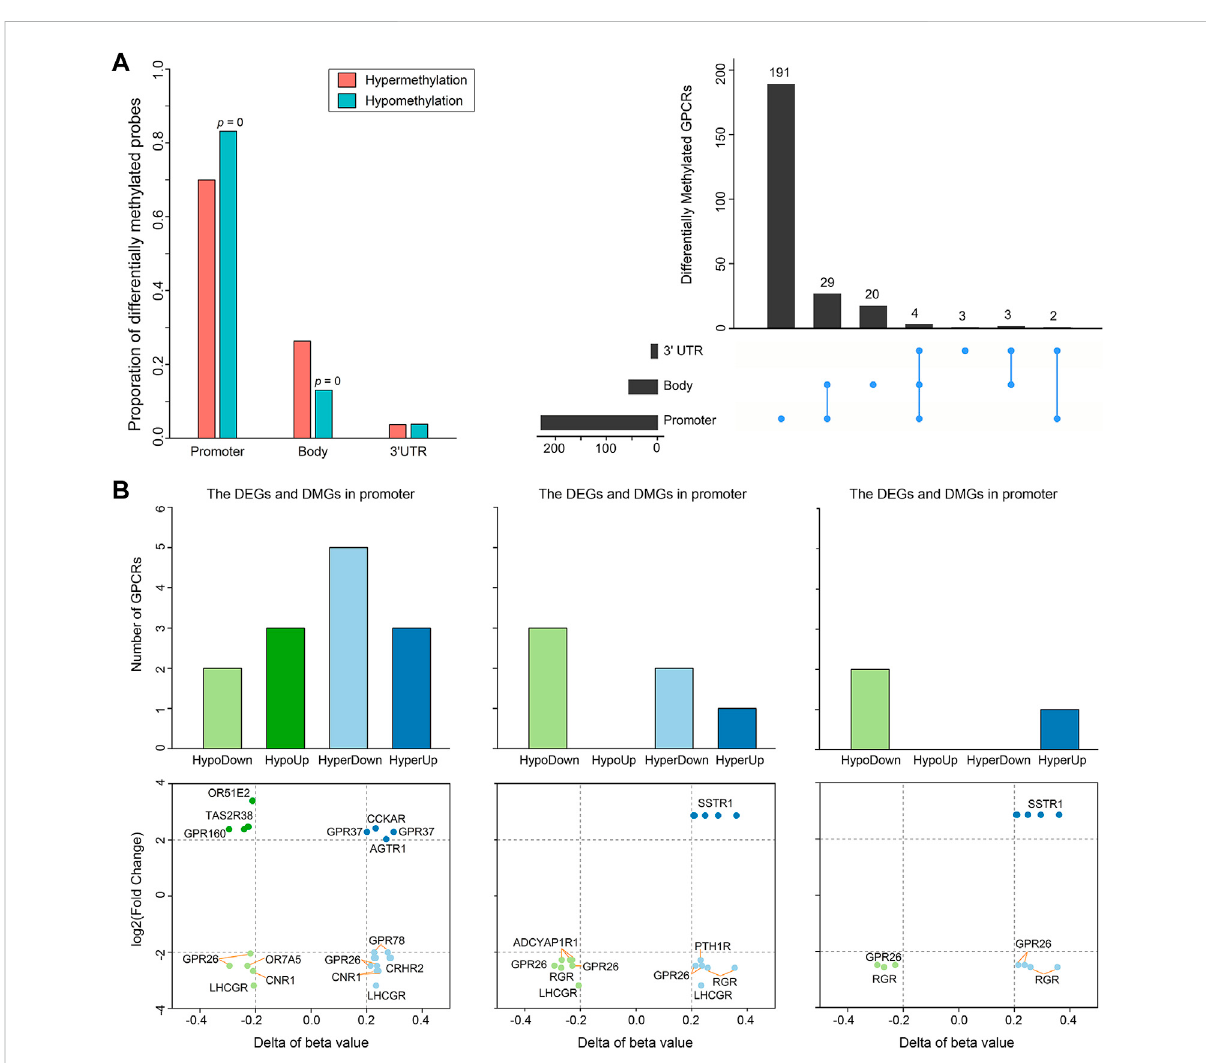
FIGURE 4 Differential methylation of GPCRs in the 491 PRAD patients. (A) Bar plot and Upset showing the number of DMGpcrs. (B) Bar plots and scatter plots showing the number and identity of DMEGs, respectively.